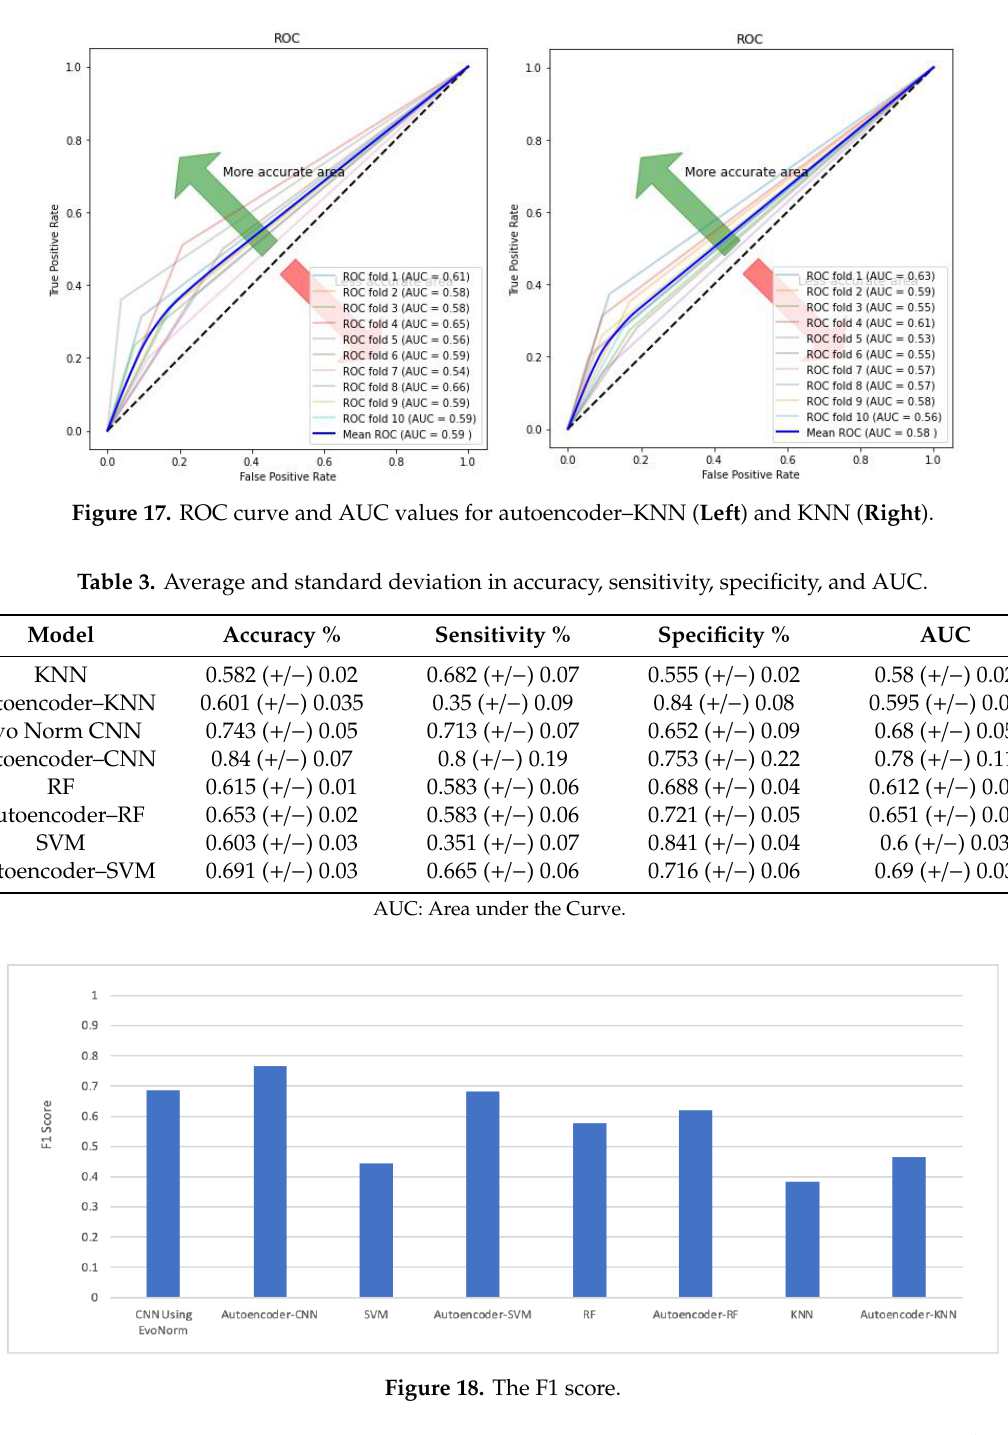
Figure 16. ROC curve and AUC values for autoencoder–RF ( Left ) and RF ( Right ).